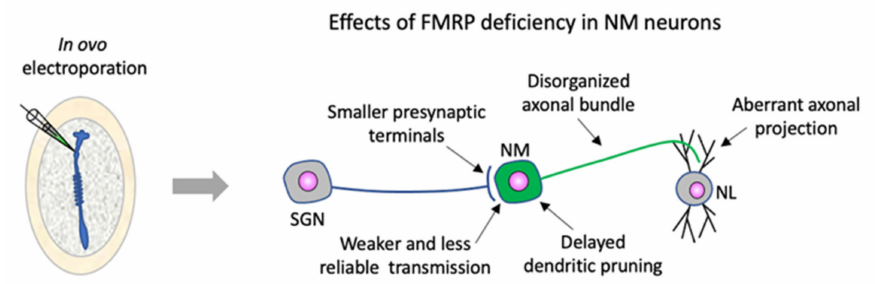
Figure 3. Site-specific FMRP functions in the chicken NM circuit. In ovo electroporation of FMRP- shRNA or CRISPR-mediated KO constructs into NM precursor cells at embryonic day 2 (left). Five distinct phenotypes were observed at subcellular levels later in development during axon navigation and circuit assembly (right). Abbreviations: SGN, spiral ganglion neurons; NM, nucleus magnocellularis; NL, nucleus laminaris; FMRP, Fragile X mental retardation